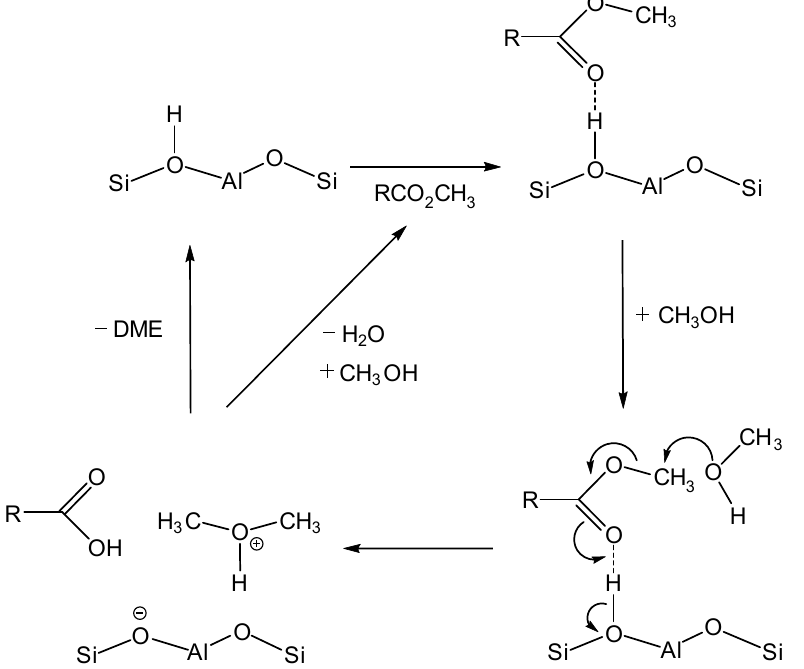
Figure 11. Indication of the reaction mechanisms of methyl ester promoted methanol dehydration to DME on zeolite.